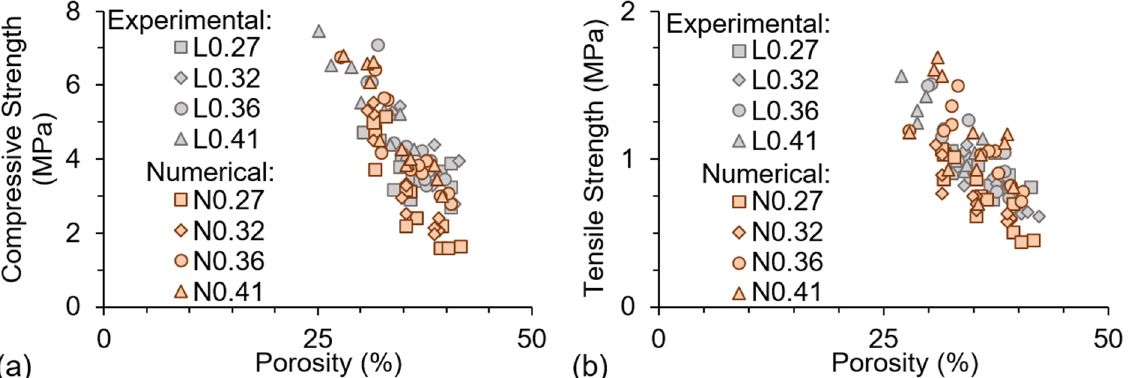
Figure 8 . Experimental and numerical results: a) compressive and b) tensile strength